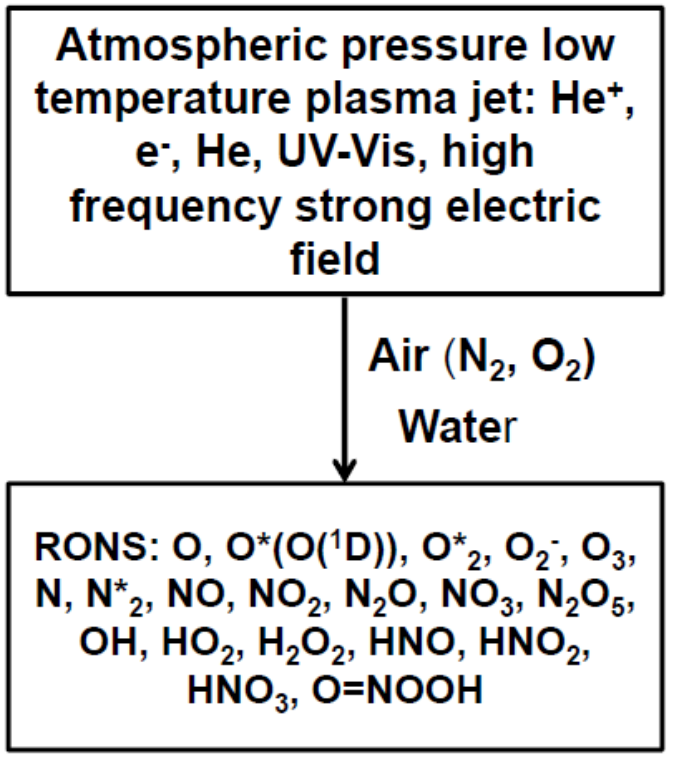
Figure 1. Diagram of RONS production with cold atmospheric pressure radio-frequency He-plasma jet at interfaces between air, plasma, and water.